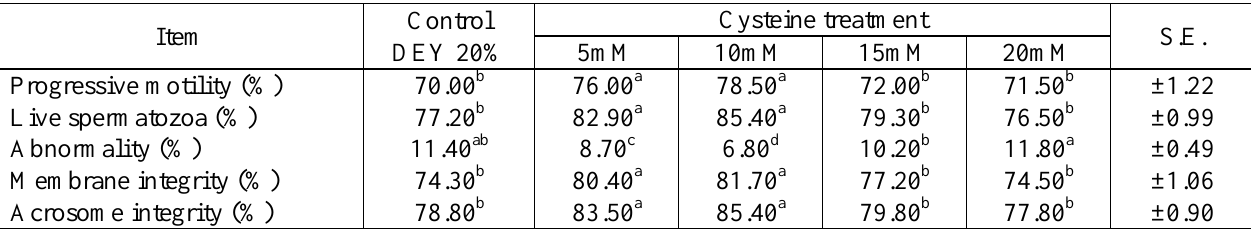
Table 1: Effect of different concentrations of Cysteine added to Holstein bull spermatozoa’s extender, after dilution (Mean ±